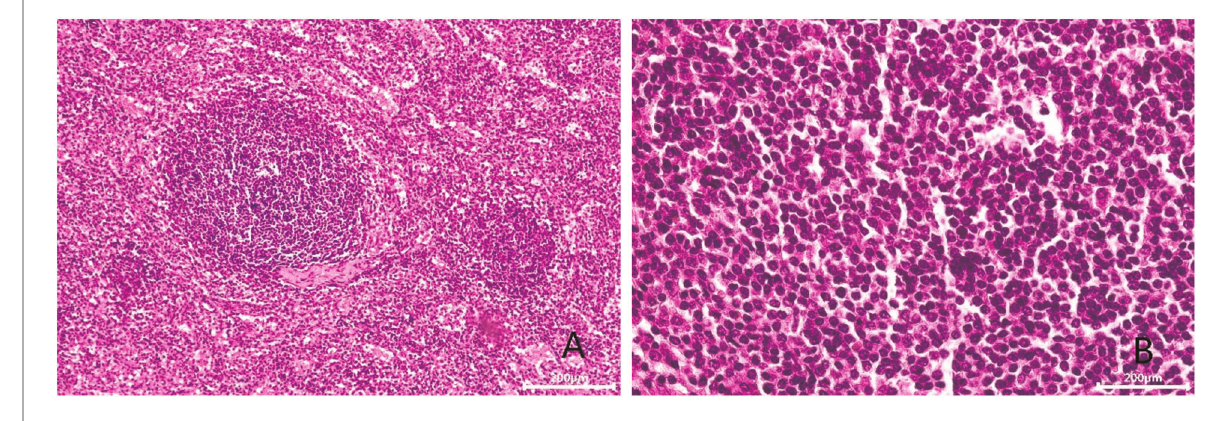
FIGURE 3 Microscopic appearance ( A,B ). Histologic magni fi cation revealed accessory splenic tissue [hematoxilyn and eosin staining, ×200 ( A ), ×400 ( B